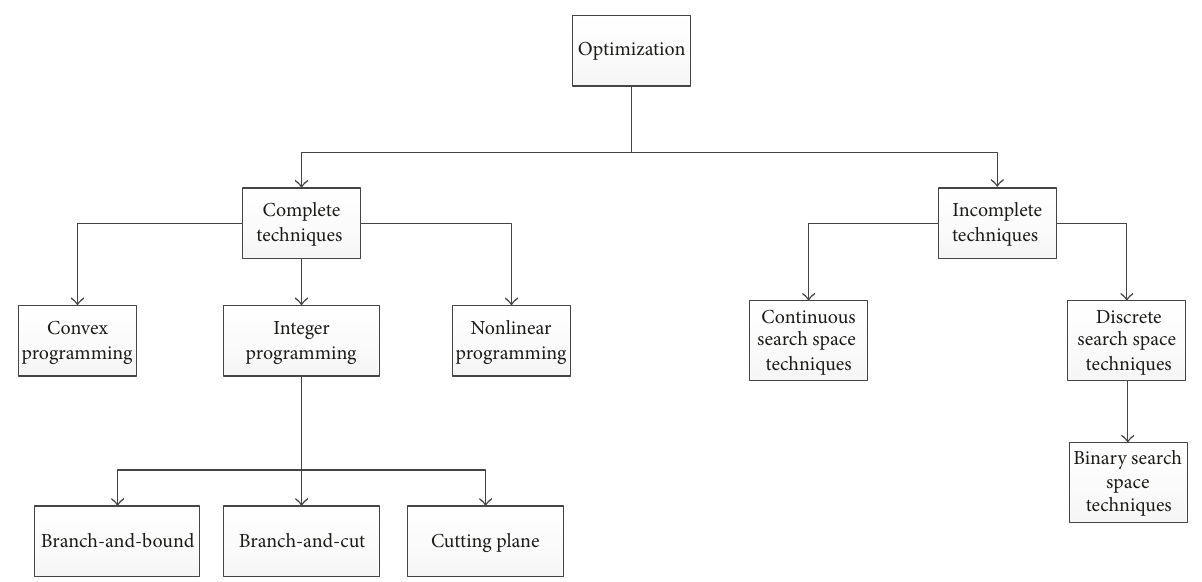
Figure 1: Optimization